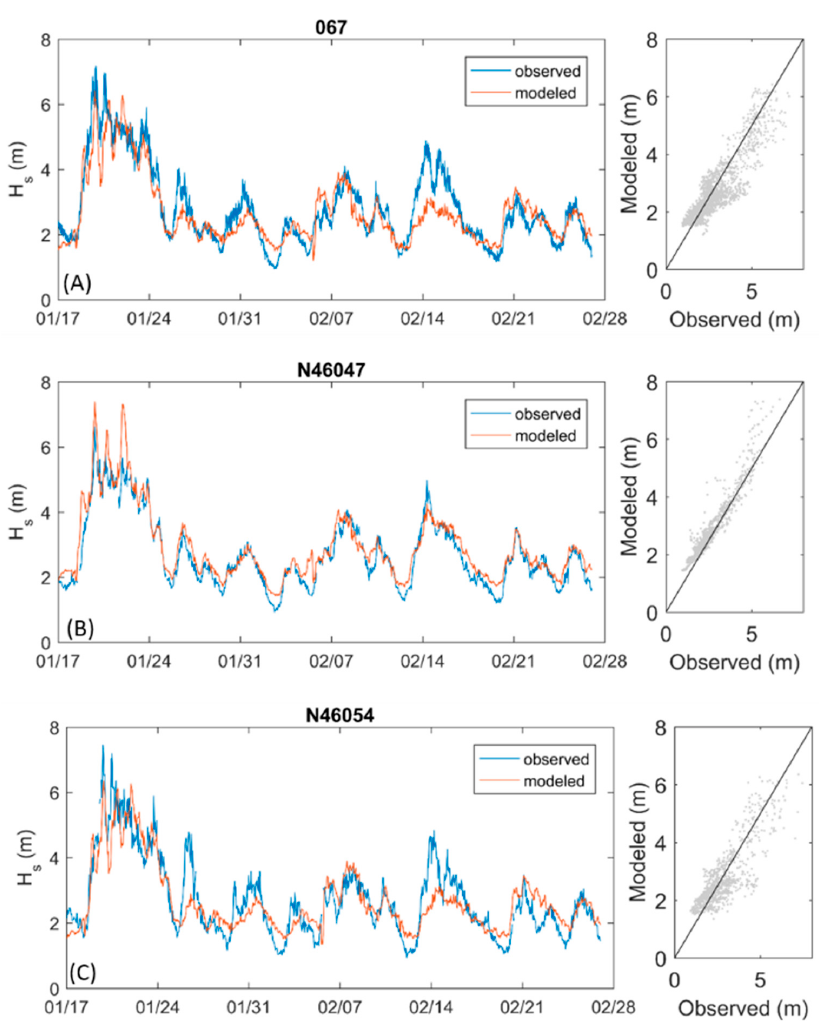
Figure 10. Time series and scatter comparisons of measured and modeled wave heights at three buoy locations within the SCB. See Appendix B for more information. locations within the SCB. See Appendix B for more